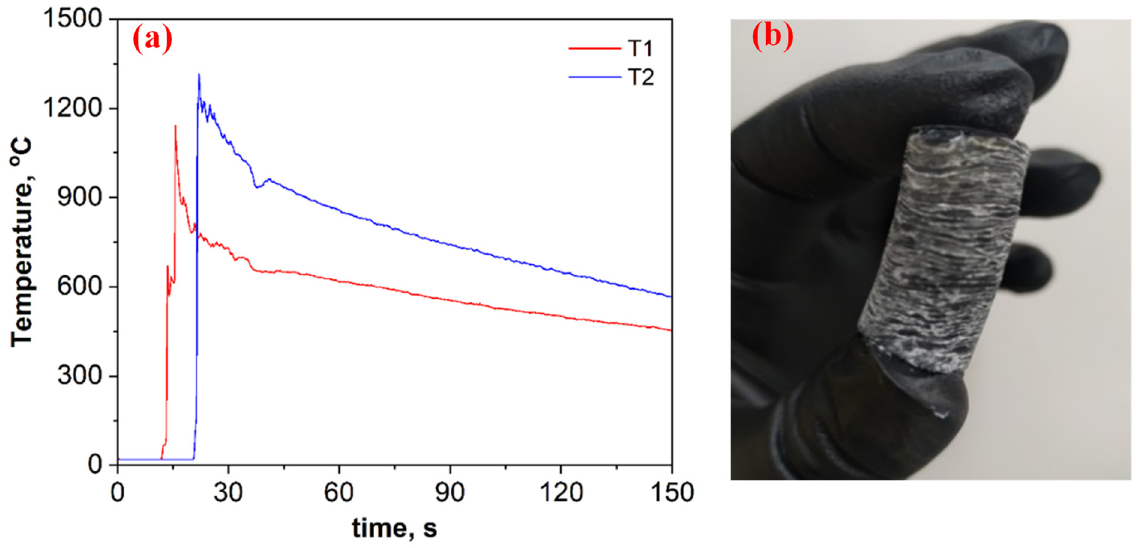
Figure 2. Time–temperature profiles for the B 2 O 3 + 0.2MgB 12 + 2.8Mg + 1.1C mixture ( a ) and the overview of the combustion product after SHS ( b ).